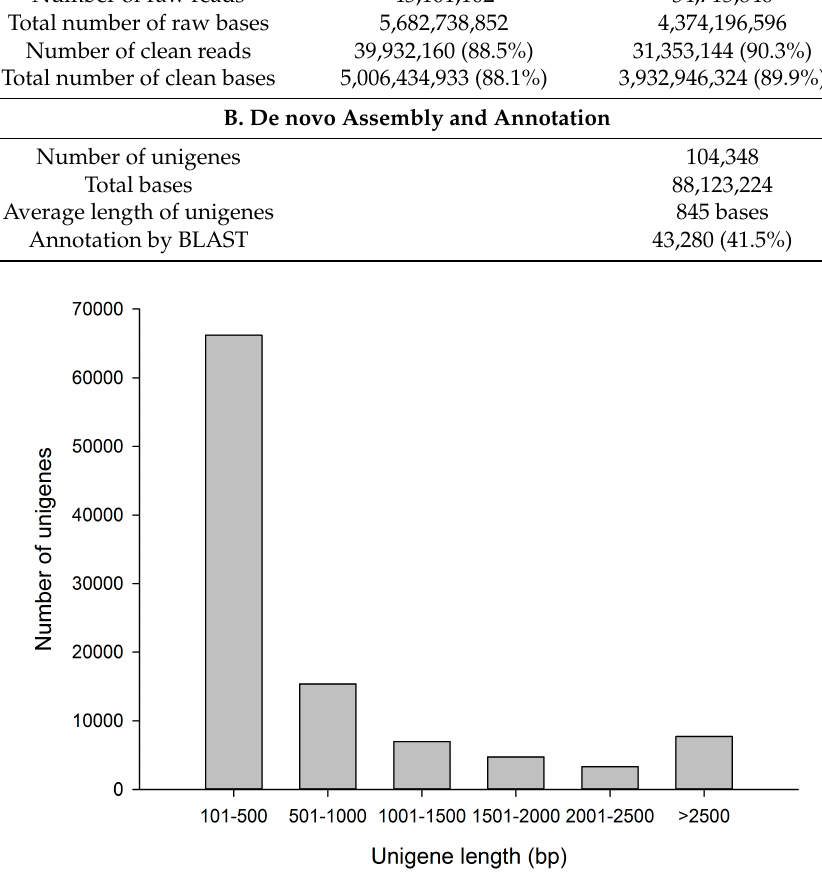
Figure 1. Length distribution of unigenes obtained from transcriptome analysis.